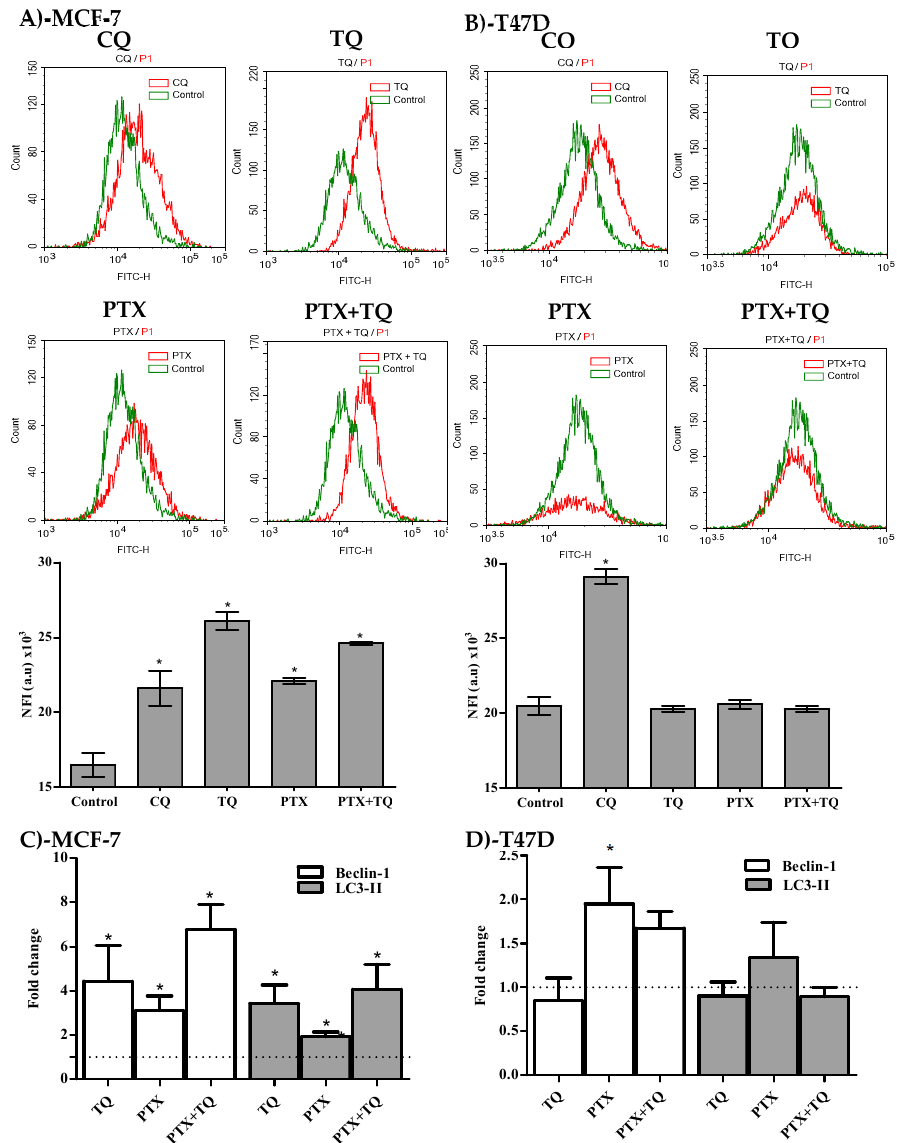
Figure 5. Autophagic cell death assessment in MCF-7 ( A ) and T47D ( B ) cells after exposure to PTX, TQ, and their combination. Cells were exposed to PTX, TQ, or their combination for 24 h, and were stained with a Cyto-ID autophagosome tracker. Net fluorescent intensity (NFI) was plotted and compared to the basal fluorescence of the control group. Gene expression fold changes for beclin-I and LC3-II were assessed for MCF-7 (C) and T47D cells ( D ). Data are presented as mean ± SD; n = 3. (*) significantly di ff erent from the control